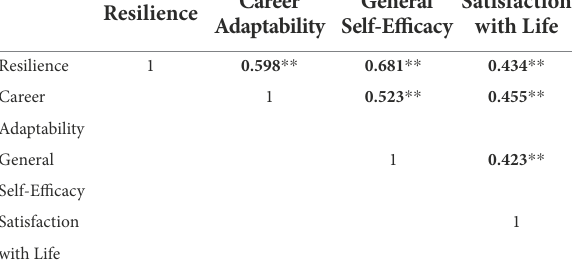
TABLE 2 Pearson’s correlation